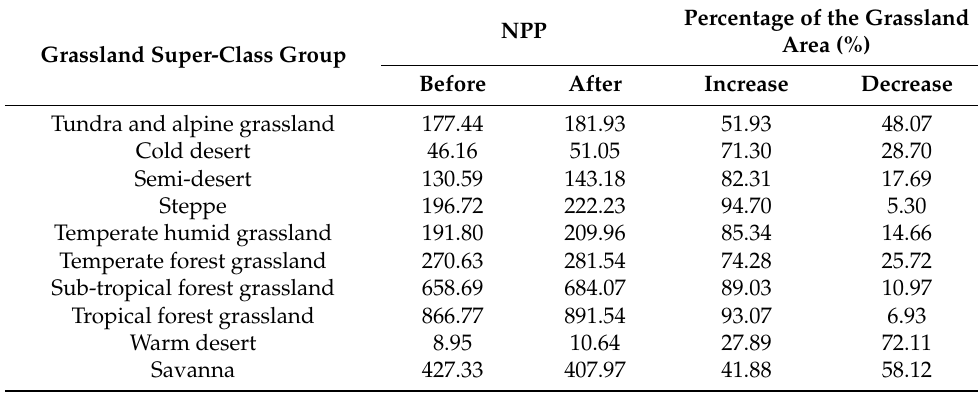
Table 2. The average climate NPP (g C m − 2 a − 1 ) and trend for all grassland super-class groups